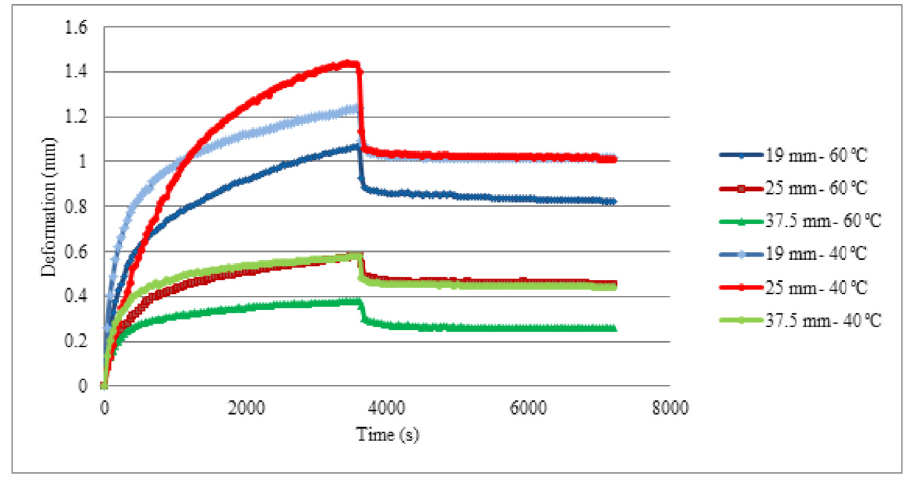
Fig. 2. Deformation of optimum mix samples under different curing methods (40 °C and 60 °C)